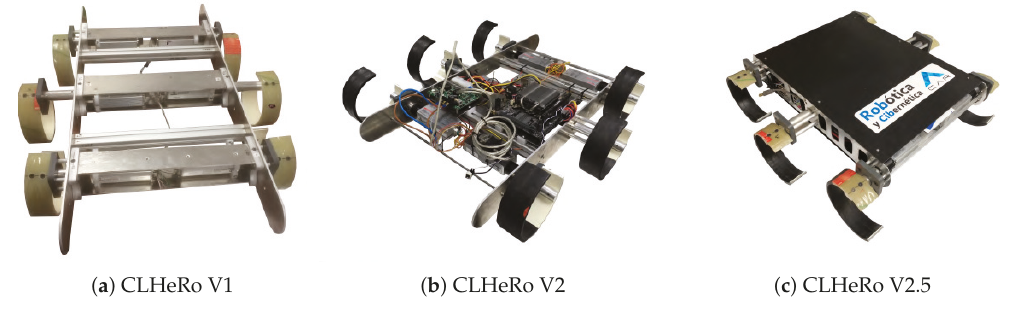
Figure 2. The three versions of the CLHeRo robot.